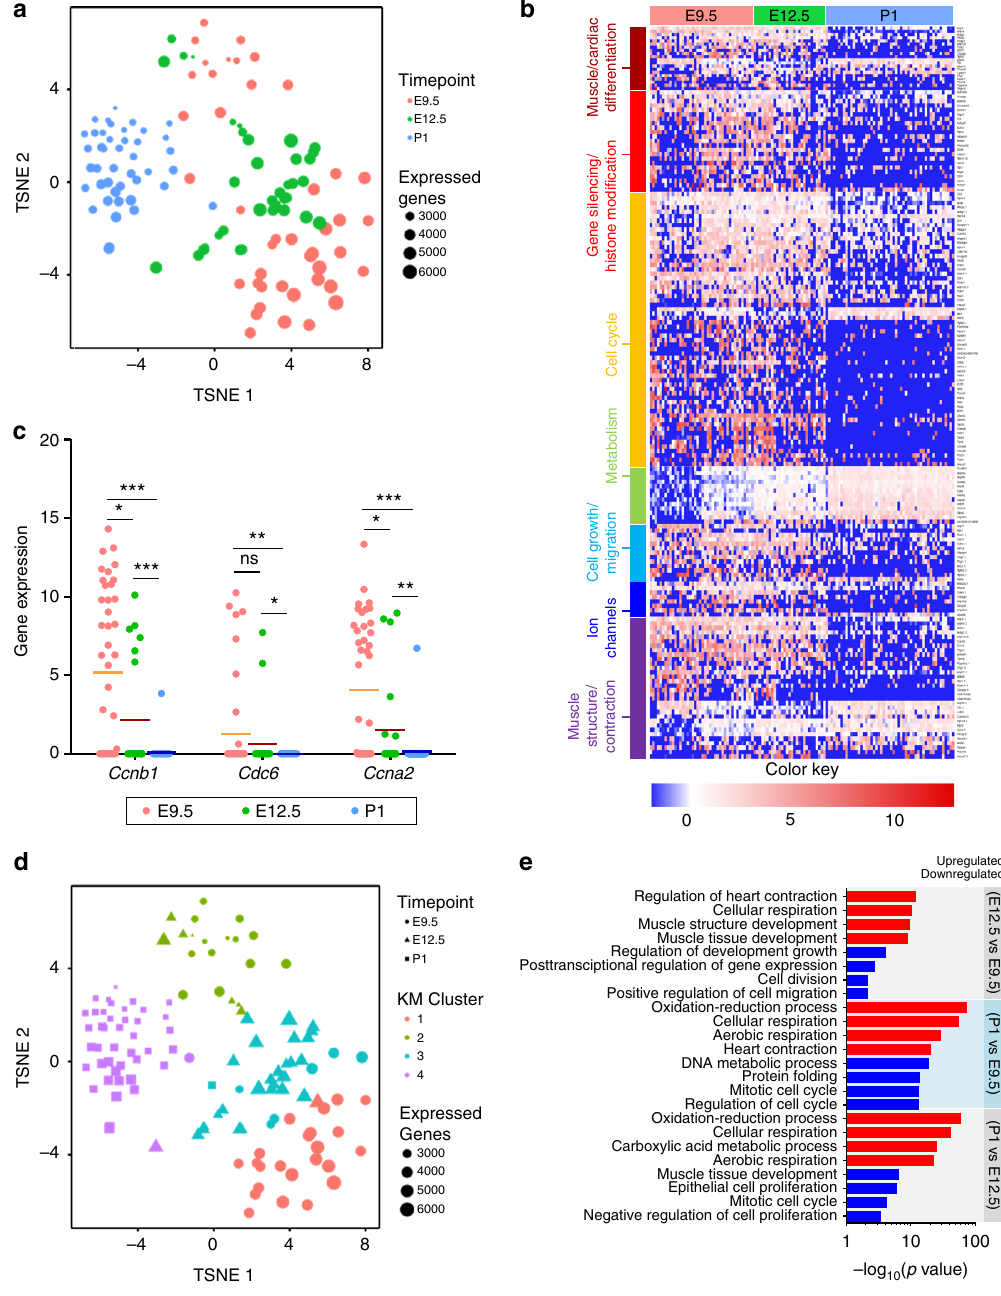
Fig. 5 Single-cell gene expression analysis reveals heterogeneity of CMs within and between developmental time points. a t-SNE revealing distribution of single cells. b Heat map analysis of single cells from different developmental time points on genes relevant to cardiac development and maturation (E9.5: n = 42, E12.5: n = 29, P1: n = 52). The full list of genes presented in the maps is also provided in Supplementary Table 1. c Expression of cell cycle-associated genes ( Ccna2, Ccnb1, Cdc6 ) from individual cells at each time point con fi rming a decline in cell cycle activity from E9.5 to P1 (Student ’ s t test), * p < 0.05, ** p < 0.01, *** p < 0.001. Mean depicted as solid line. d t-SNE with k-m-based clustering identi fi es four distinct clusters. e Gene ontology analysis of upregulated and downregulated genes between different